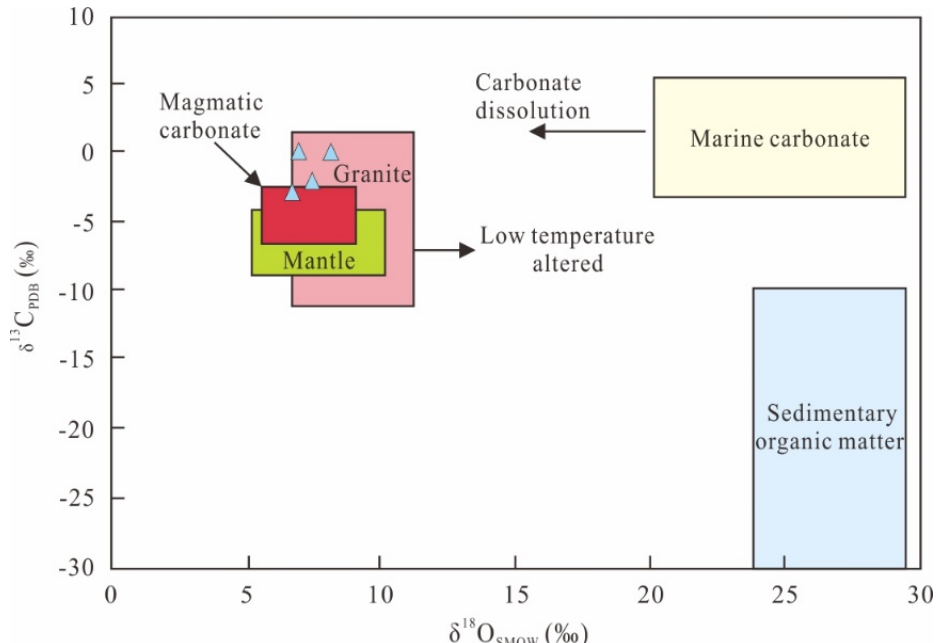
Figure 9. Plot of δ 13 C PDB vs. δ 18 O SMOW for the calcite from the Huoluotai Cu (Mo) deposit. The three main carbon sources include marine carbonate [35], sedimentary organic matter carbon [36], and magma-mantle carbonate [37].